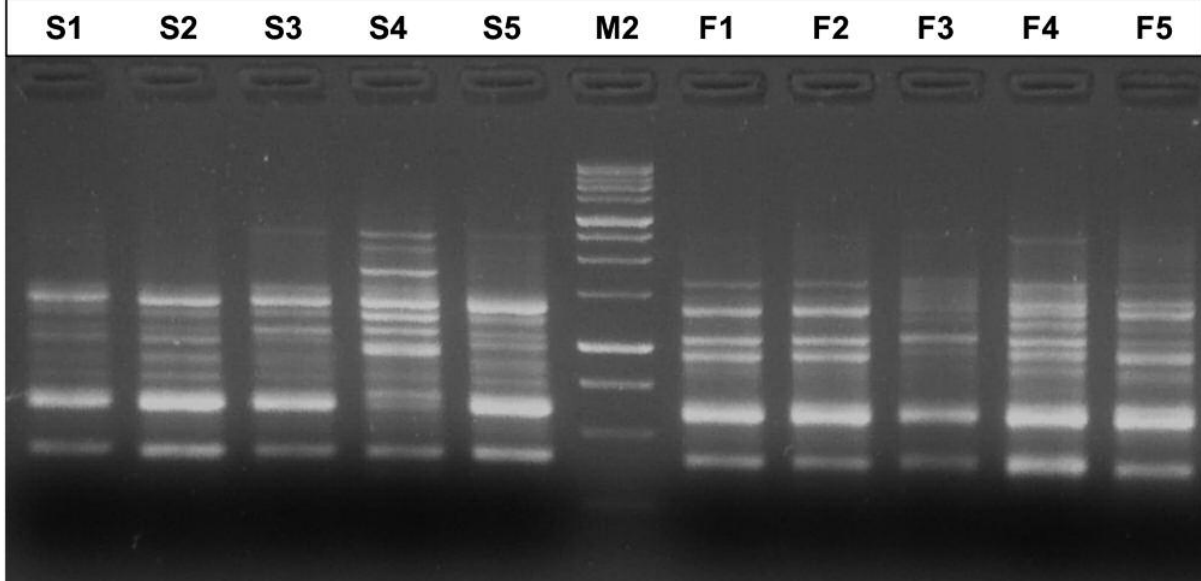
Figure 4 Comparative RAPD amplification profiles of individual plants belonging to “Stenophyllos” (samples S1 to S5) and “Fardy- phyllos” (samples F1 to F5) using primer OPG2 and a hot-start procedure. Samples were electrophoresed in a 1.8% agarose gel (1X TAE buffer). M2: 1.0 kb-DNA